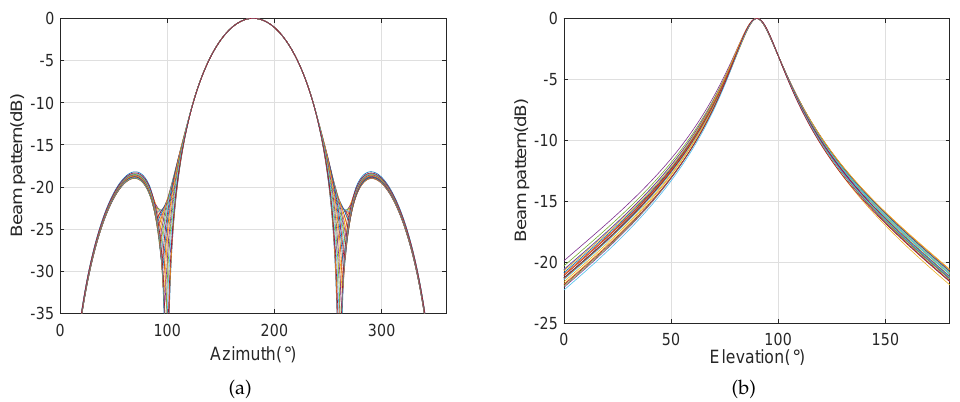
Figure 19. The beampatterns on the azimuth and elevation planes in the presence of steering vector error, where the amplitude of the error is equal to 0.001. ( a ) Beampattern on the azimuth plane; ( b ) beampattern on the elevation plane.